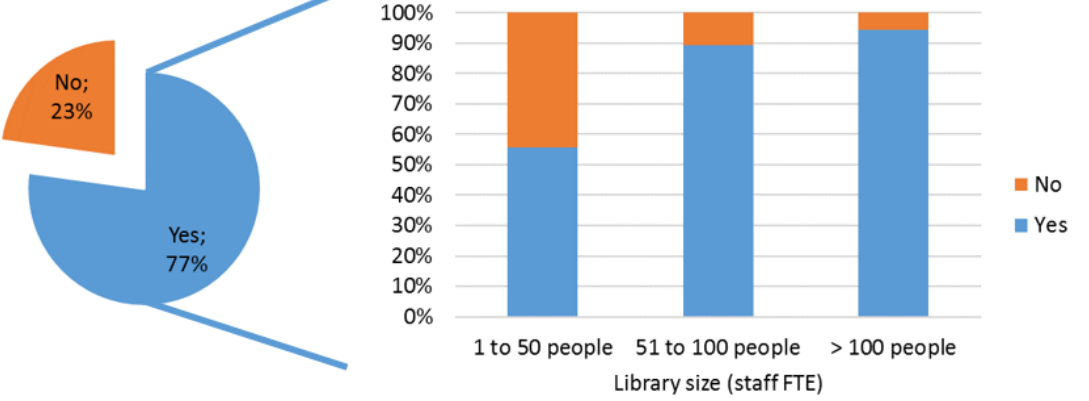
Figure 2. Provision of research support services and relationship to library size.